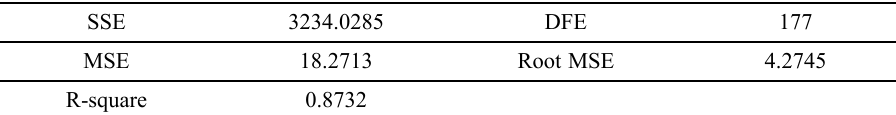
Table 5. One way fixed model, volume as dependent variable